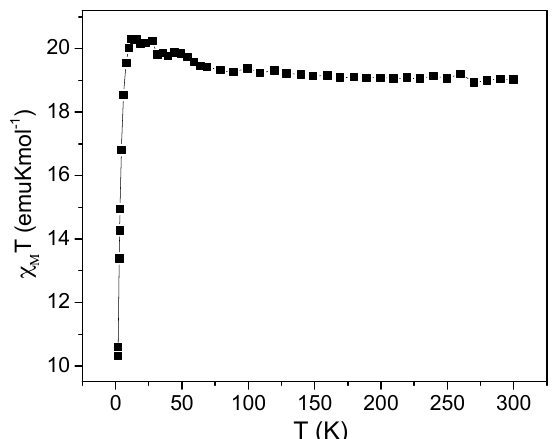
Figure 3. Temperature dependence of the χ M T product (per 5.3 cobalt and 2.7 nickel dications) of 1 observed at 1 kOe.